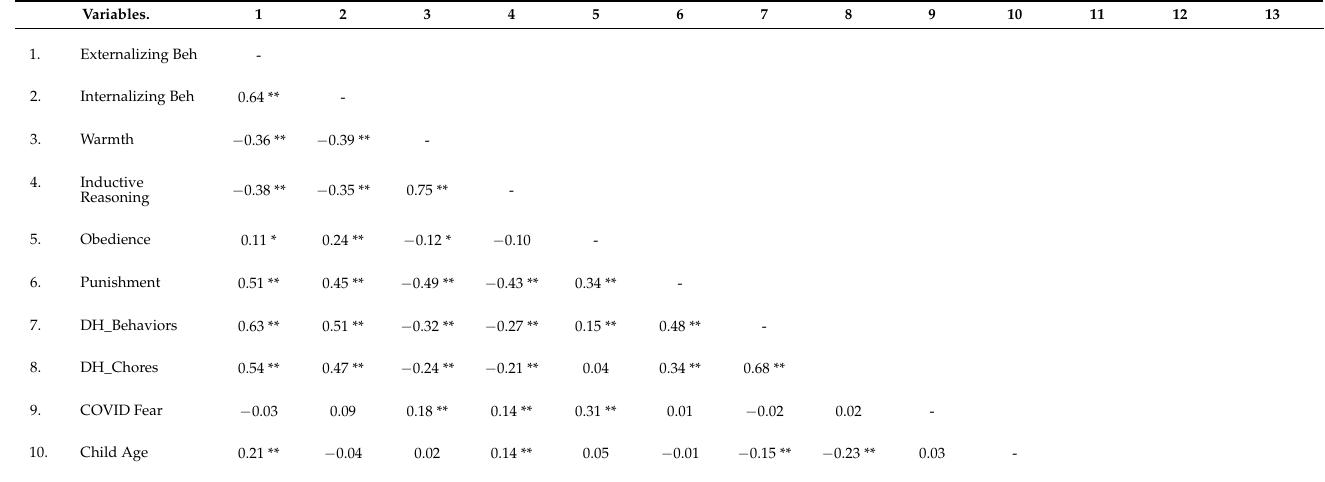
Table 1. Bivariate correlations and descriptive statistics for the study